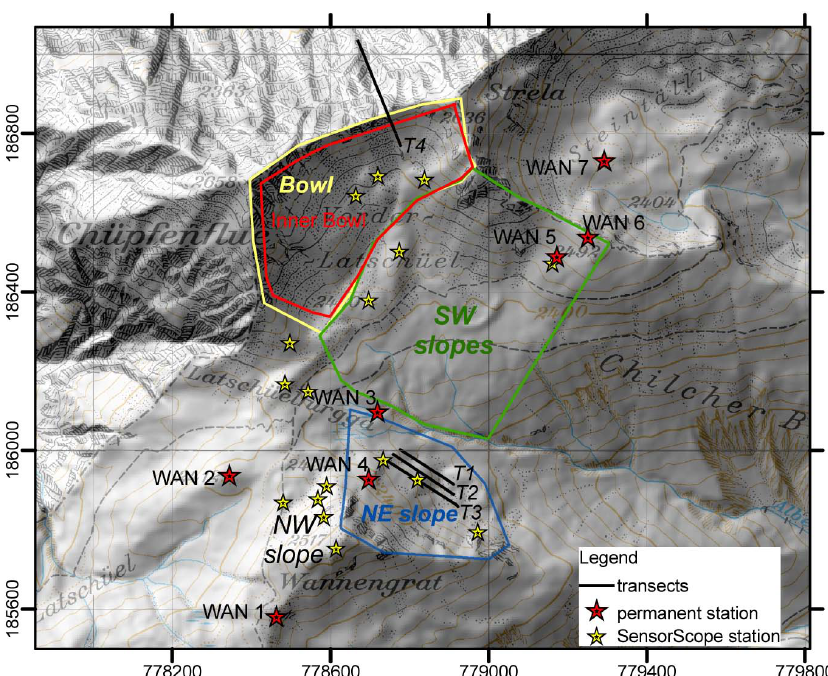
Fig. 1. Location of the study site in the Wannengrat area near Davos. The x and y-axes indicate Swiss coordinates in meters. Colored lines enclose the four sub-areas investigated. SensorScope stations are marked with yellow stars and permanent weather stations (WAN 1–7) are marked with red stars. The four black lines (numbered from T1 to T4) mark the transects shown in Figs. 5, 8, 10, 11 and Table 2. (basemap: Pixelkarte PK 25 ©2009 swisstopo